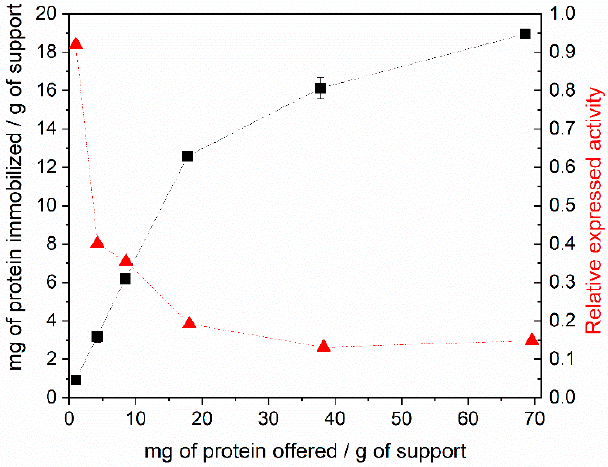
Figure 6. Protein immobilized ( ■ ) and effectiveness factor ( ▲ ) vs. protein load offered to the immobilization of NPD on agarose-glyoxyl at 20 °C and pH 10.0 for 24 h reaction time.